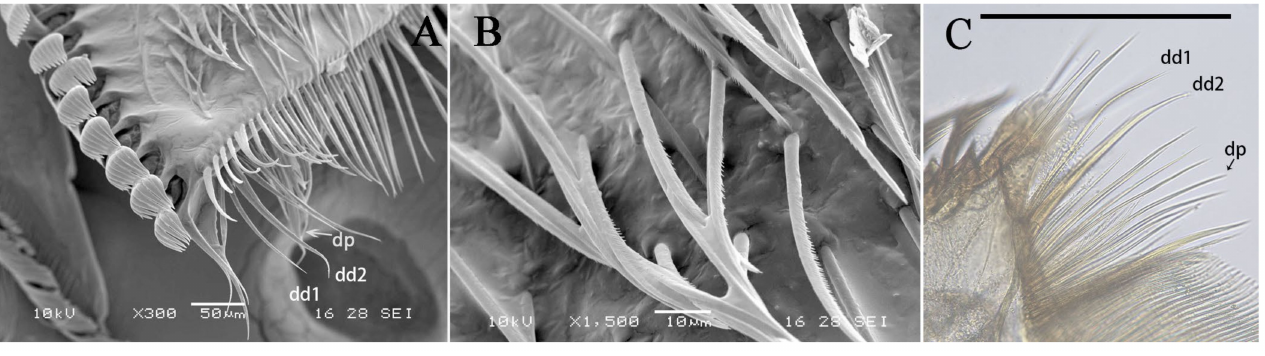
Figure 3. Maxillae of Maculogenia ngi maxillae (A,B: SEM photo, C: digital photo): ( A , C ) Dentisetae enlarged (distal dentisetae and proximal dentisetae are marked); ( B ) enlarged scattered setae on ventral surface. Scale bars: ( C ) = 0.1